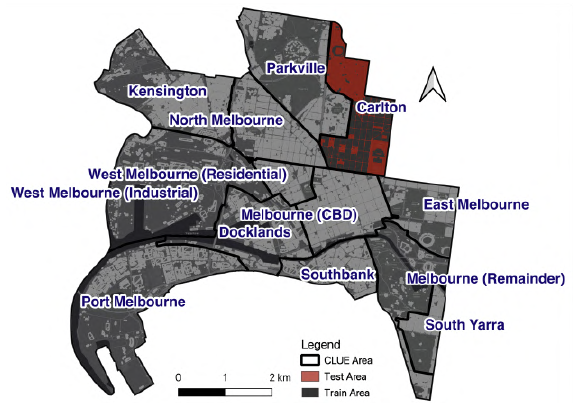
Figure 1 . Census of Land Use and Employment (CLUE) areas of the City of